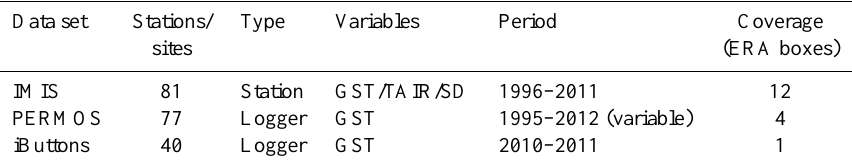
Table 2. Description of evaluation data sets used in this study. Data set Stations/ Type